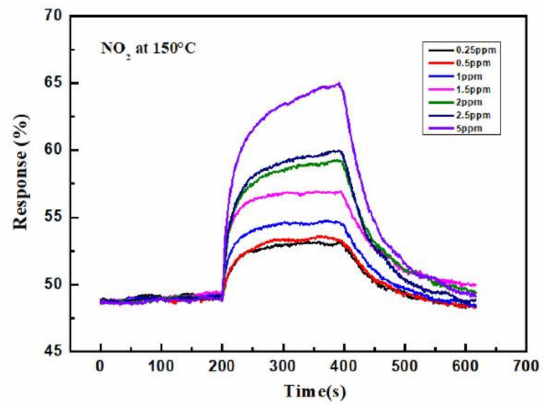
Figure 8. The response curve of the sensor to different concentrations of NO 2 at 150 ◦